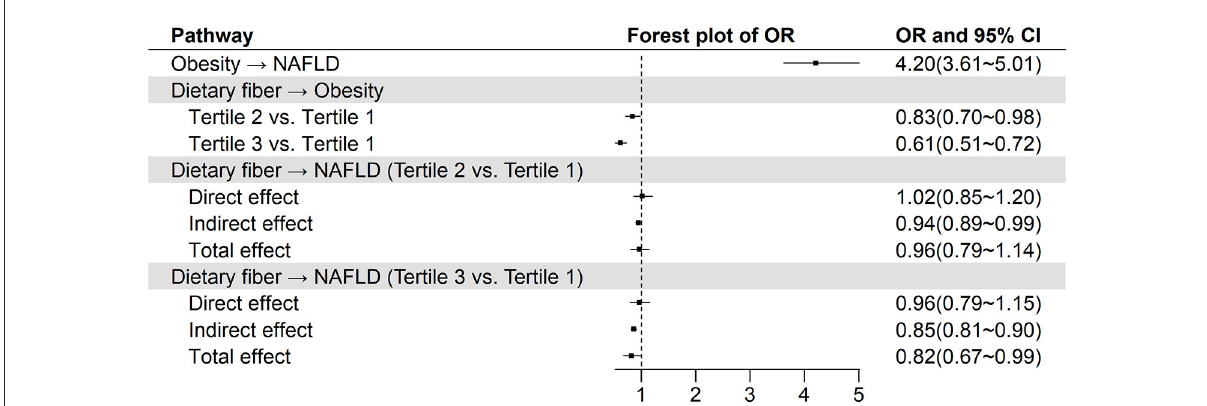
FIGURE2 The relationship between dietary fiber and NAFLD from mediation analysis with controlling obesity as a mediator a . CI, confidence interval; NAFLD, non-alcoholic fatty liver disease; OR: odds ratio. a Model was adjusted for adjusted for age, sex, smoking, race/ethnicity, education, ratio of family income to poverty, physical activity, total energy, hypertension, and